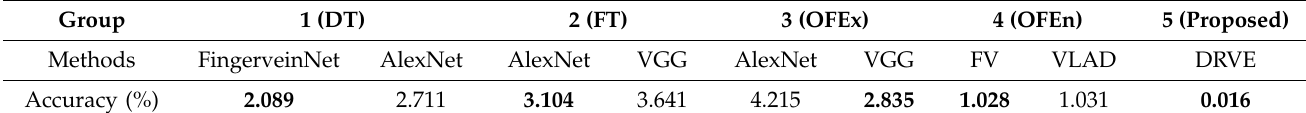
Table 2. EER (%) with different pre-trained models; the benchmark performance of the first four groups are highlighted. Group 1 represents direct training (DT) from scratch; group 2 represents fine-tuning (FT); group 3 represents off-line feature extractor (OFEx); group 4 represents off-line feature encoding (OFEn).